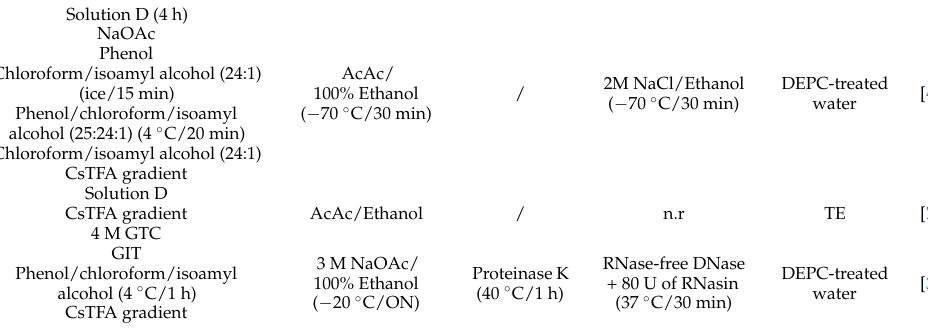
Table 4. Cont. Solution D (4 h)